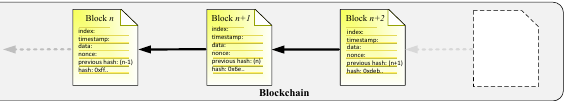
Figure 1. Blockchain concept